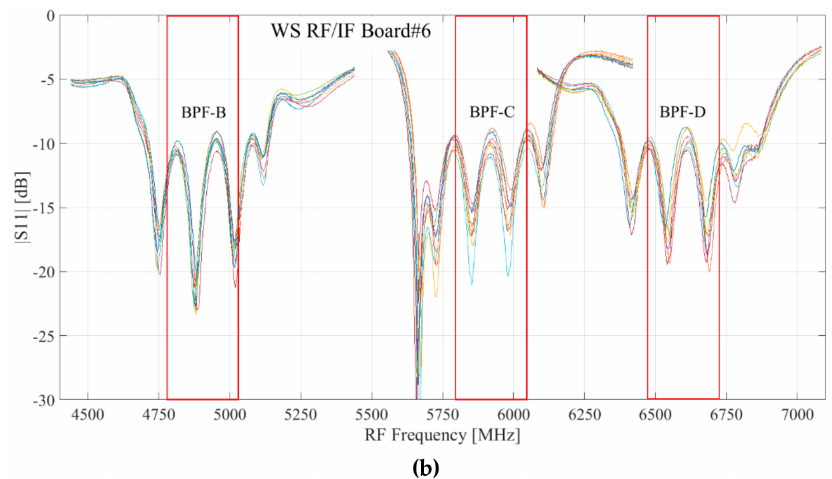
Figure 21. VNA test results of the eight channels of board #6. Cumulated measures for the selection of BPF-B, BPB-C and BPF-D (LO frequencies set at 5425 MHz, 6430 MHz and 7095 MHz, respectively). ( a ) LSB gain from SMA RF input connector to MCX IF output connector; ( b ) Reflection coe ffi cient at SMA RF input connector. The vertical red lines delimit the nominal band edges of the three filters. The di ff erent colors refer to the eight di ff erent tested channels.